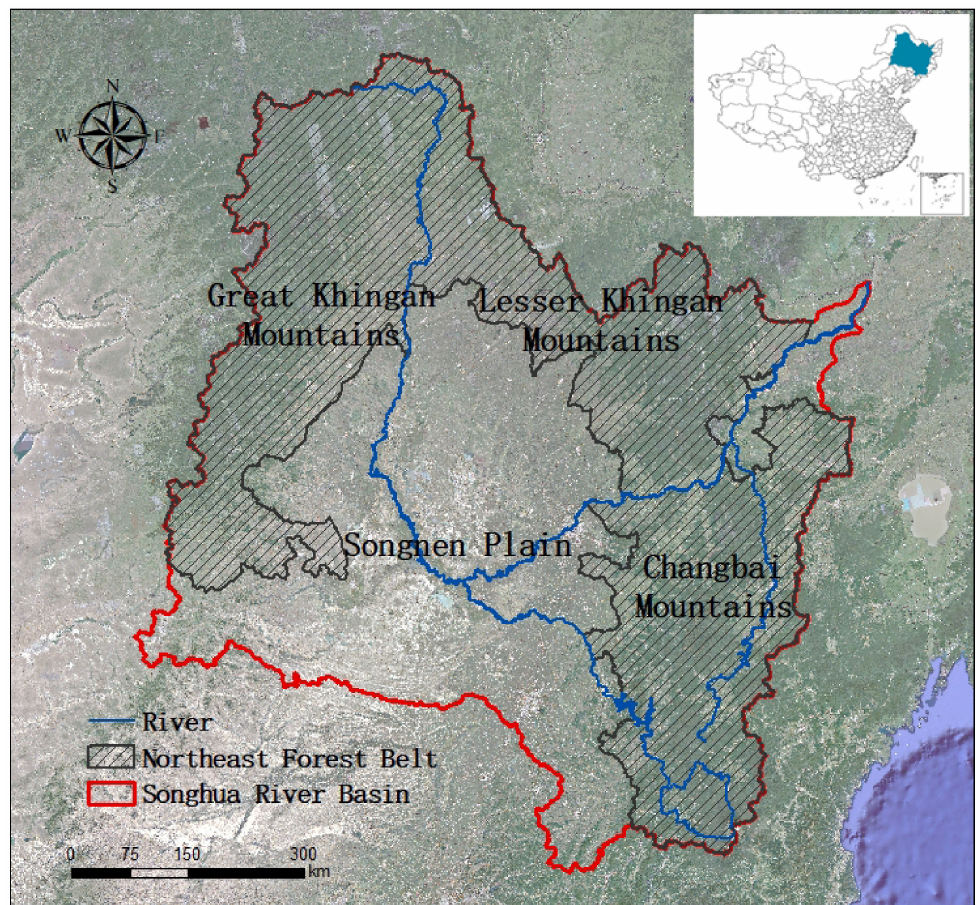
Figure 1. Location of the study